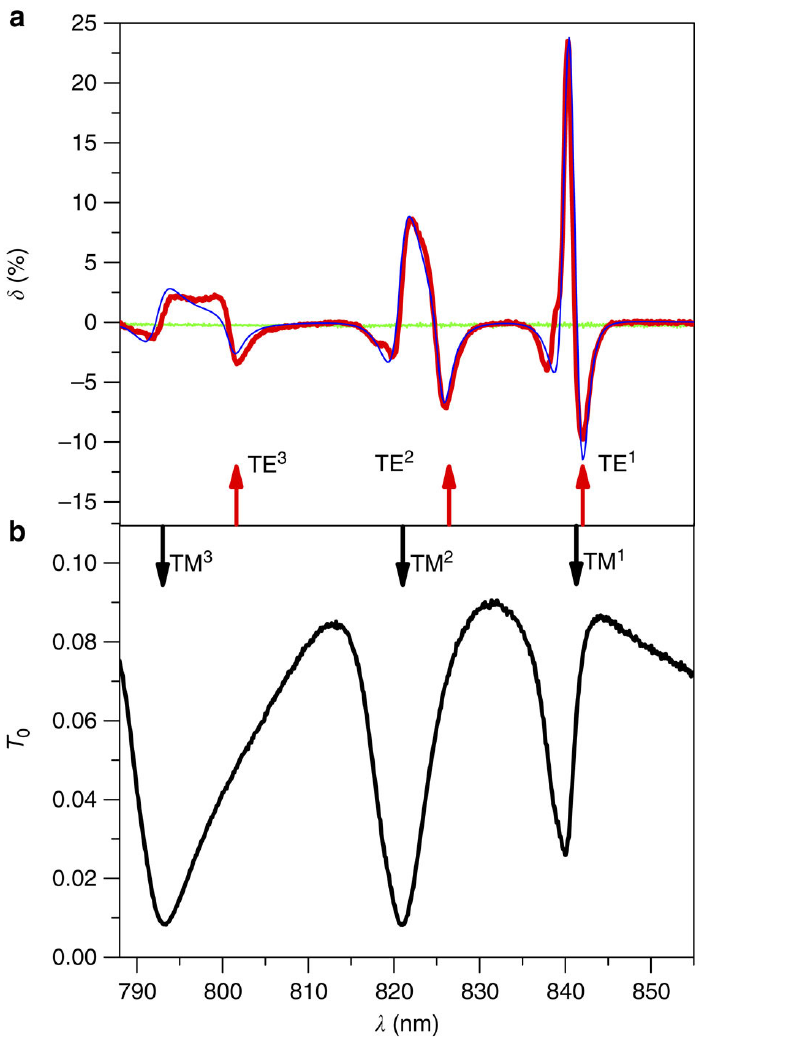
Figure 4. ( a ) Spectrum of the LMPIE when a static magnetic field reaching almost the saturation value. Blue curve shows calculated δ . There is no LMPIE for the bare magnetic film (green curve); ( b ) Spectrum of the optical transmittance for the demagnetised structure. Black and red arrows indicate calculated spectral positions of the quasi-TM and quasi-TE resonances, respectively. The modes are denoted by the number of their H E field maxima along the z axis. The light is TM-polarized and hits the sample under y normal